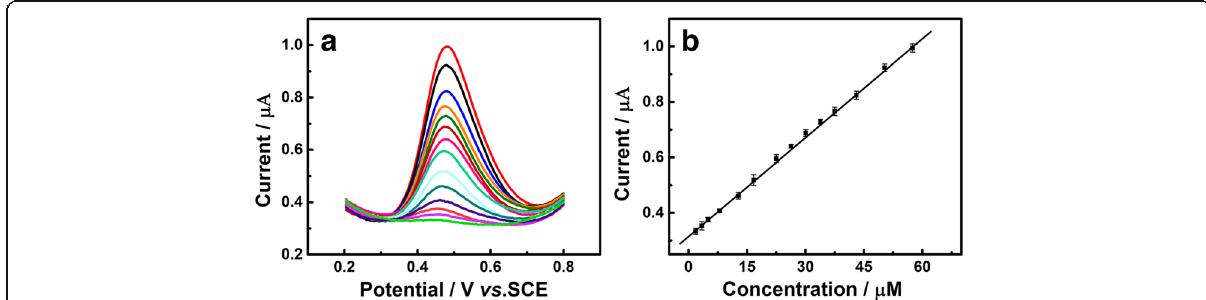
Fig. 7 a DPV curves of the Au/GCE in 0.1 M PBS (pH 7.0) at different concentrations of UA. b Plots of anodic peak currents vs. concentration of